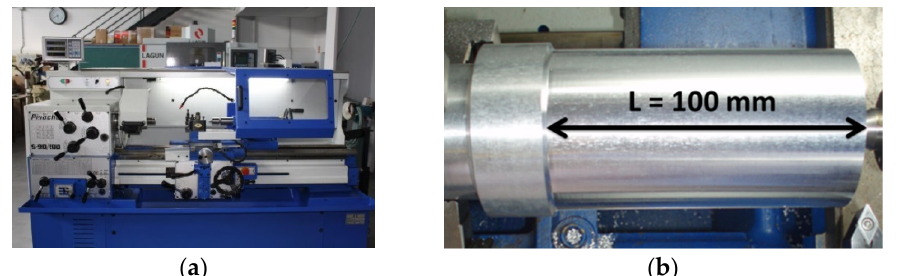
Figure 1. ( a ) Horizontal lathe used in turning tests; ( b ) Cylindrical test bars.